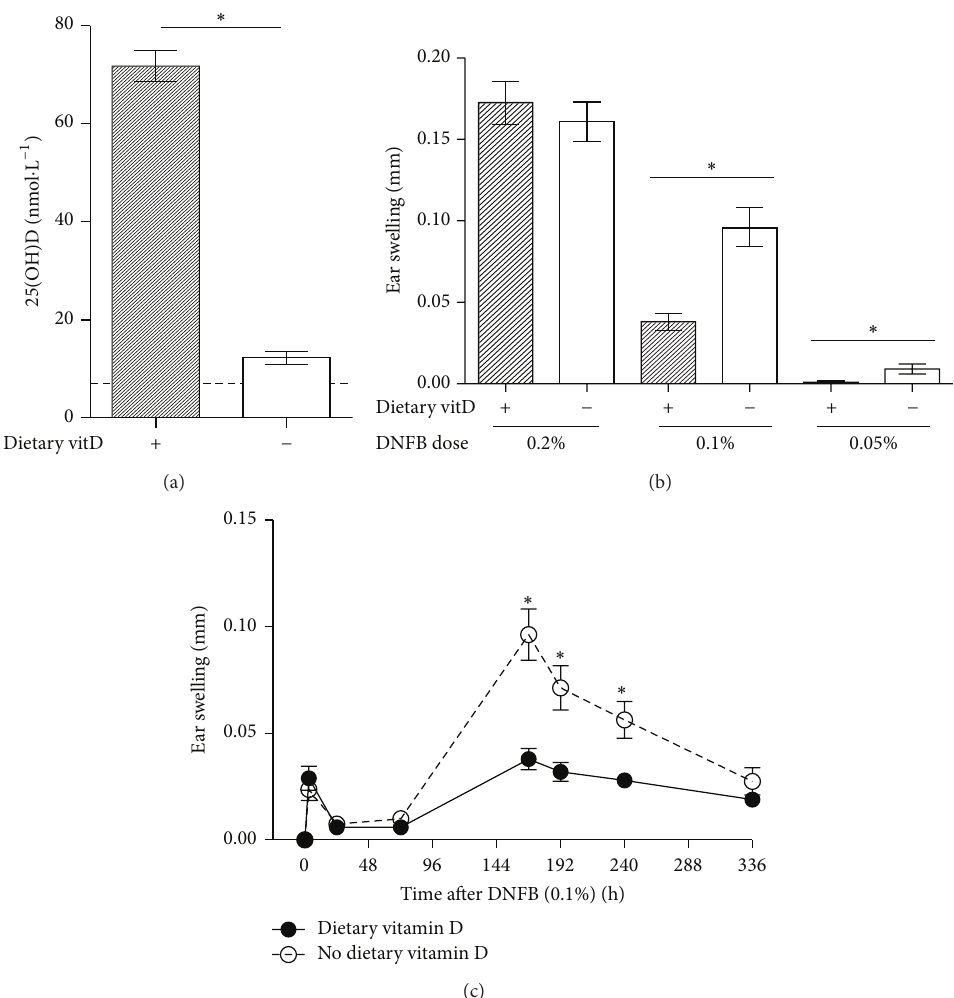
Figure 1: Dietary vitamin D suppressed the biphasic ear swelling response induced by the hapten DNFB. Female offspring born to vitamin D 3 - (vitD-) replete (+) or vitamin D 3 -deficient ( − ) BALB/c mothers were maintained on vitamin D 3 -replete or vitamin D 3 -deficient diets (resp.). (a) Serum 25(OH)D 3 levels of female offspring at 8 weeks of age (mean ± SEM for ≥ 5 mice per group). The broken line indicates the level of detection for 25(OH)D 3 (7pg/mL). In (b), the ear pinnae of mice were sensitized with 0.2, 0.1, or 0.05% DNFB and the ear swelling response was measured at the second peak of the biphasic response (144h). In (c), the ear pinnae of mice were sensitized with 0.1% DNFB and the resulting biphasic ear swelling response was measured over 305 h. Data are shown as mean ± SEM in (b) and (c) for 8–12 ear pinnae of 4–6 mice per treatment ( ∗ 𝑝 < 0.05 ). In (b), data are from a single experiment and in (c) they are representative of 2